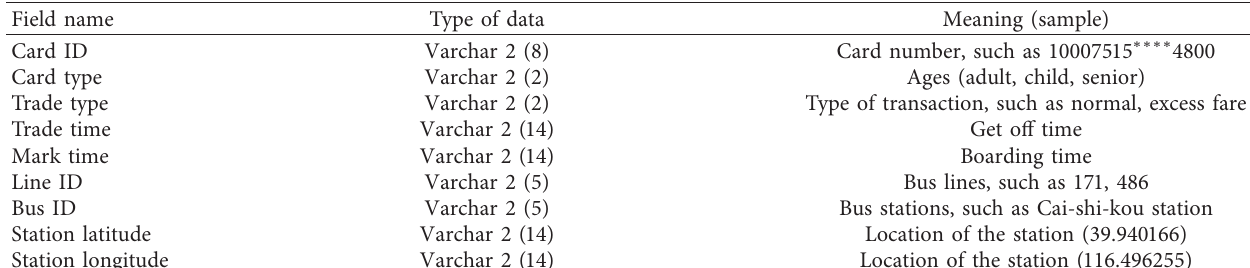
Table 2: The raw data format of the bus network.